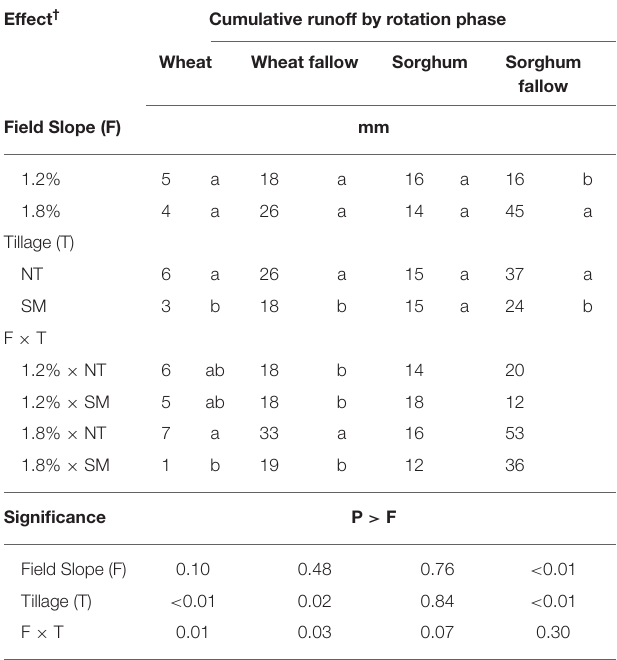
( Table 1 ) provided growing season weed control in